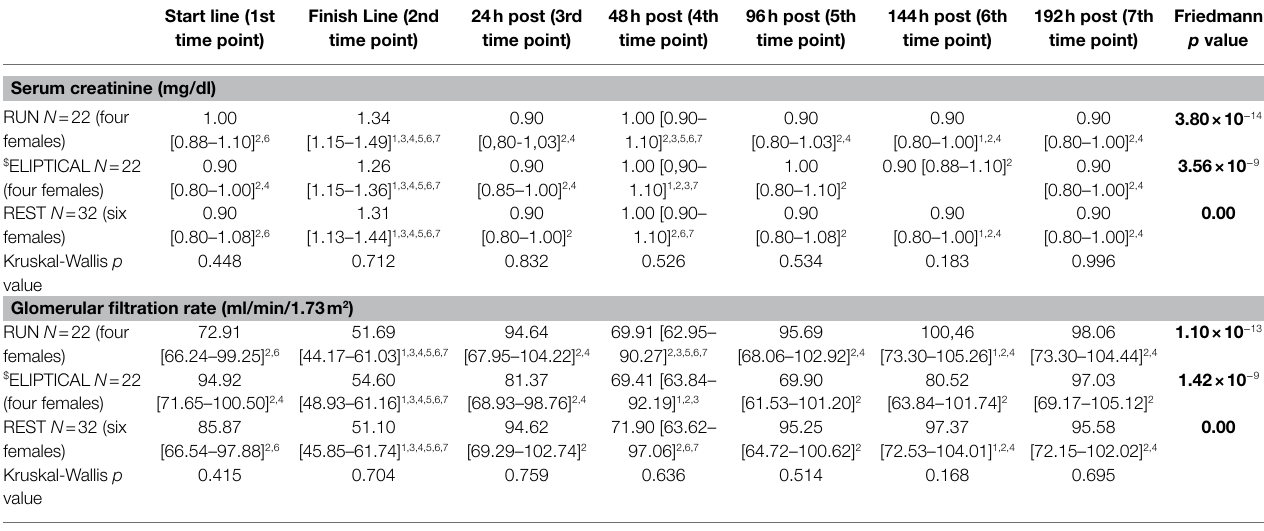
TABLE 3 | Evolution of serum creatinine (sCr) and the glomerular filtration rate (GFR) in the three groups during the whole